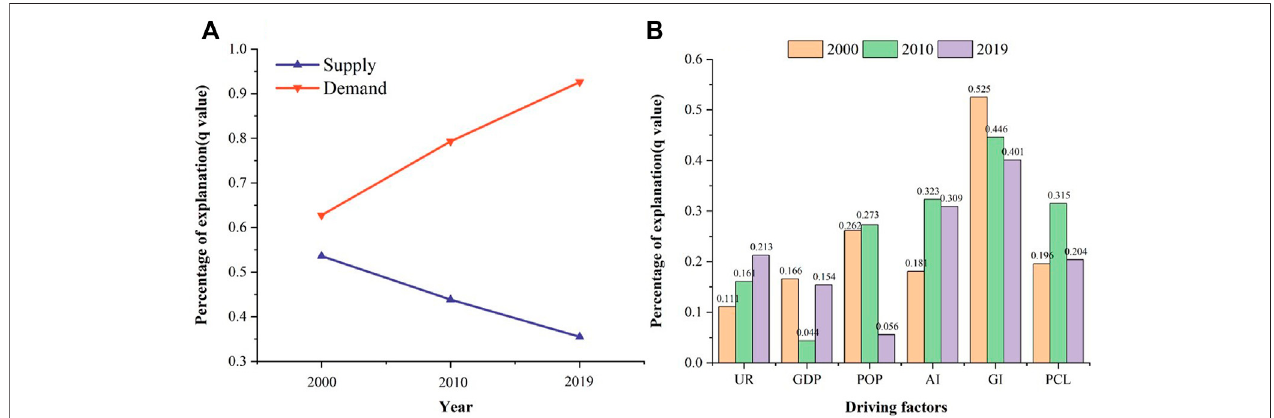
FIGURE 7 | Percentage of explanation (q value) for supply and demand of carbon sequestration service (A) ; Percentage of explanation (q value) for each driving factor in 2000, 2010 and 2019 (B) (UR: urbanization rate, GDP: gross domestic product per capita, POP: population density, AI: agricultural input, GI: grazing intensity, PCL: proportion of construction land).